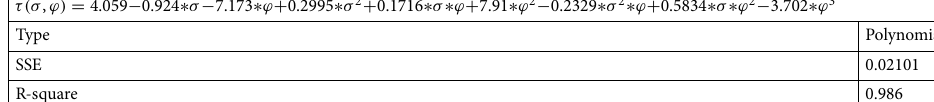
Table 6. Empirical tortuosity–porosity-sigma correlation for porous media. Sum of squared error of prediction (SSE) and R-squared for the possible correlation.